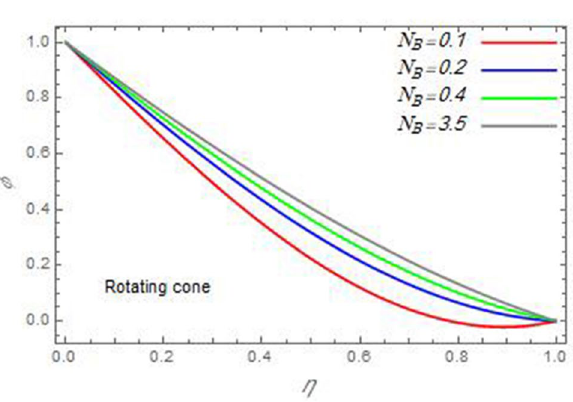
Figure 27. The nanoparticles volume fraction distribution ϕ is plotted versus the axial variable η in the case of stationary disc to depict the effect of the Brownian motion parameter N B